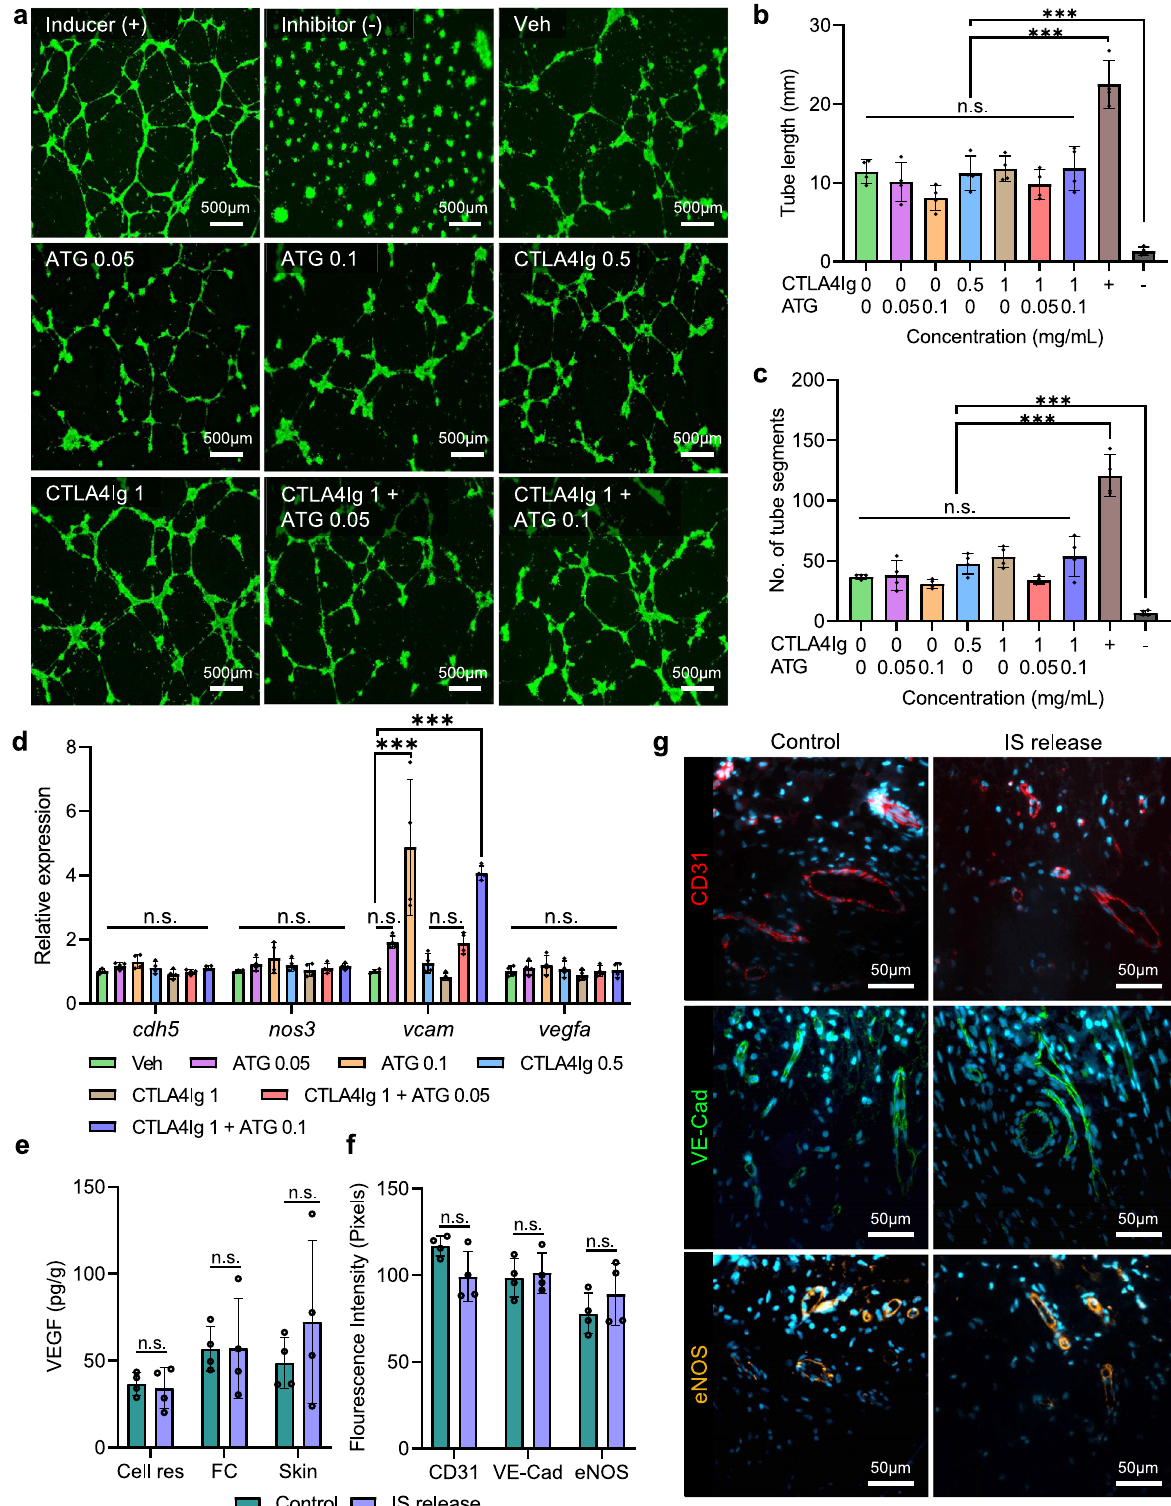
Taken together, we conclude that: (1) the pre-vascularized NICHE microenvironment was conducive to islet engraftment, (2) immuno- suppression was needed to observe therapeutic bene fi t, and (3) local and systemicimmunosuppressionwere equally effective inpreventing graft rejection and preserving islet